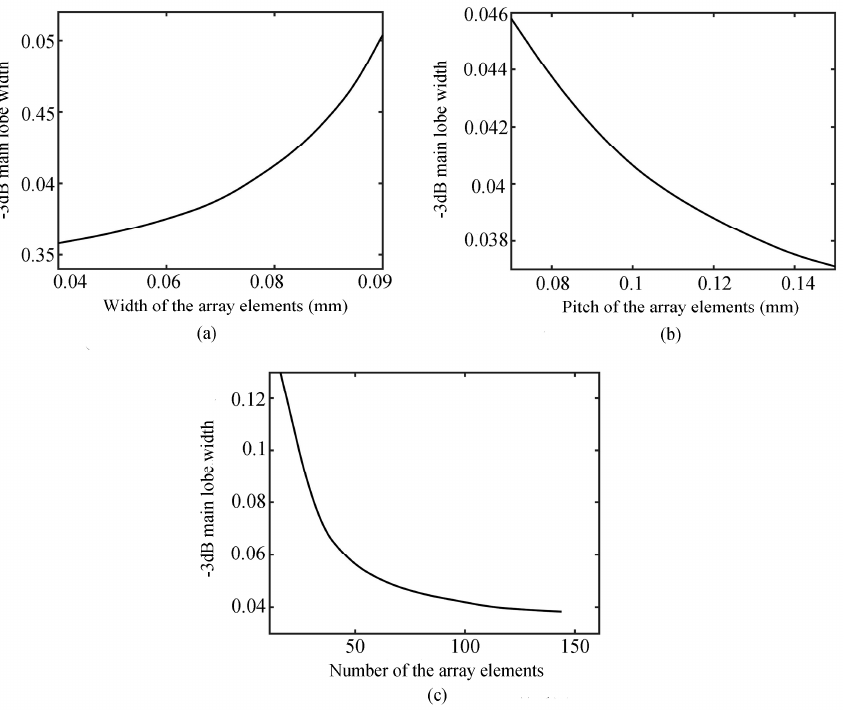
Figure 4. Relationship curve of array width ( a ), pitch ( b ), and number ( c ) with the transverse sound field of the − 3 dB main lobe width.